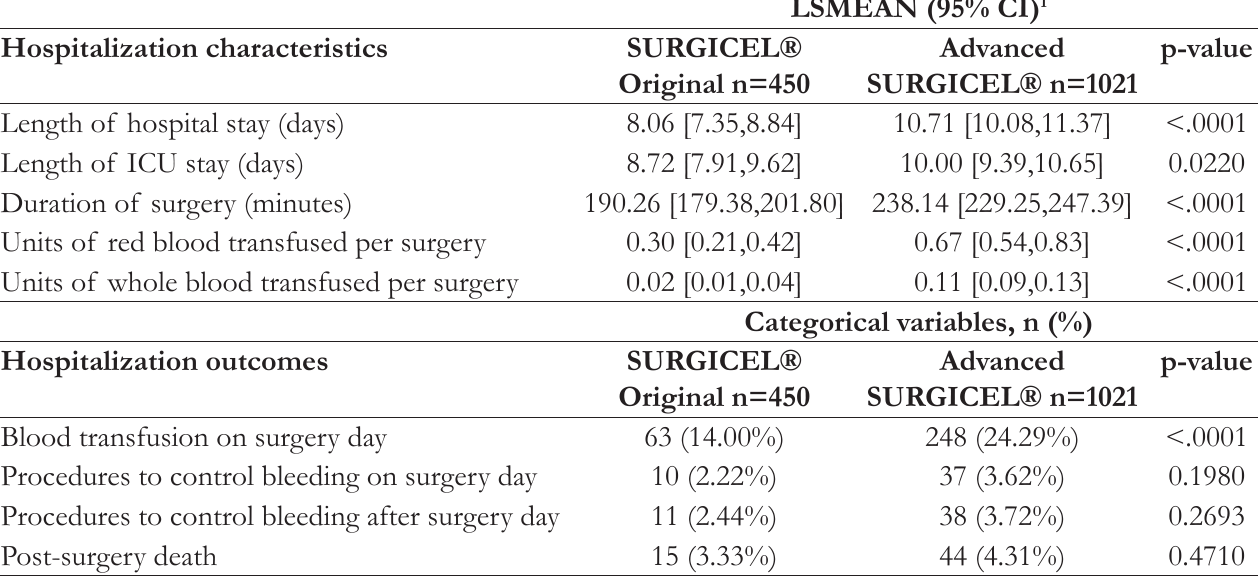
Table 3. Surgery case characteristics by product type,